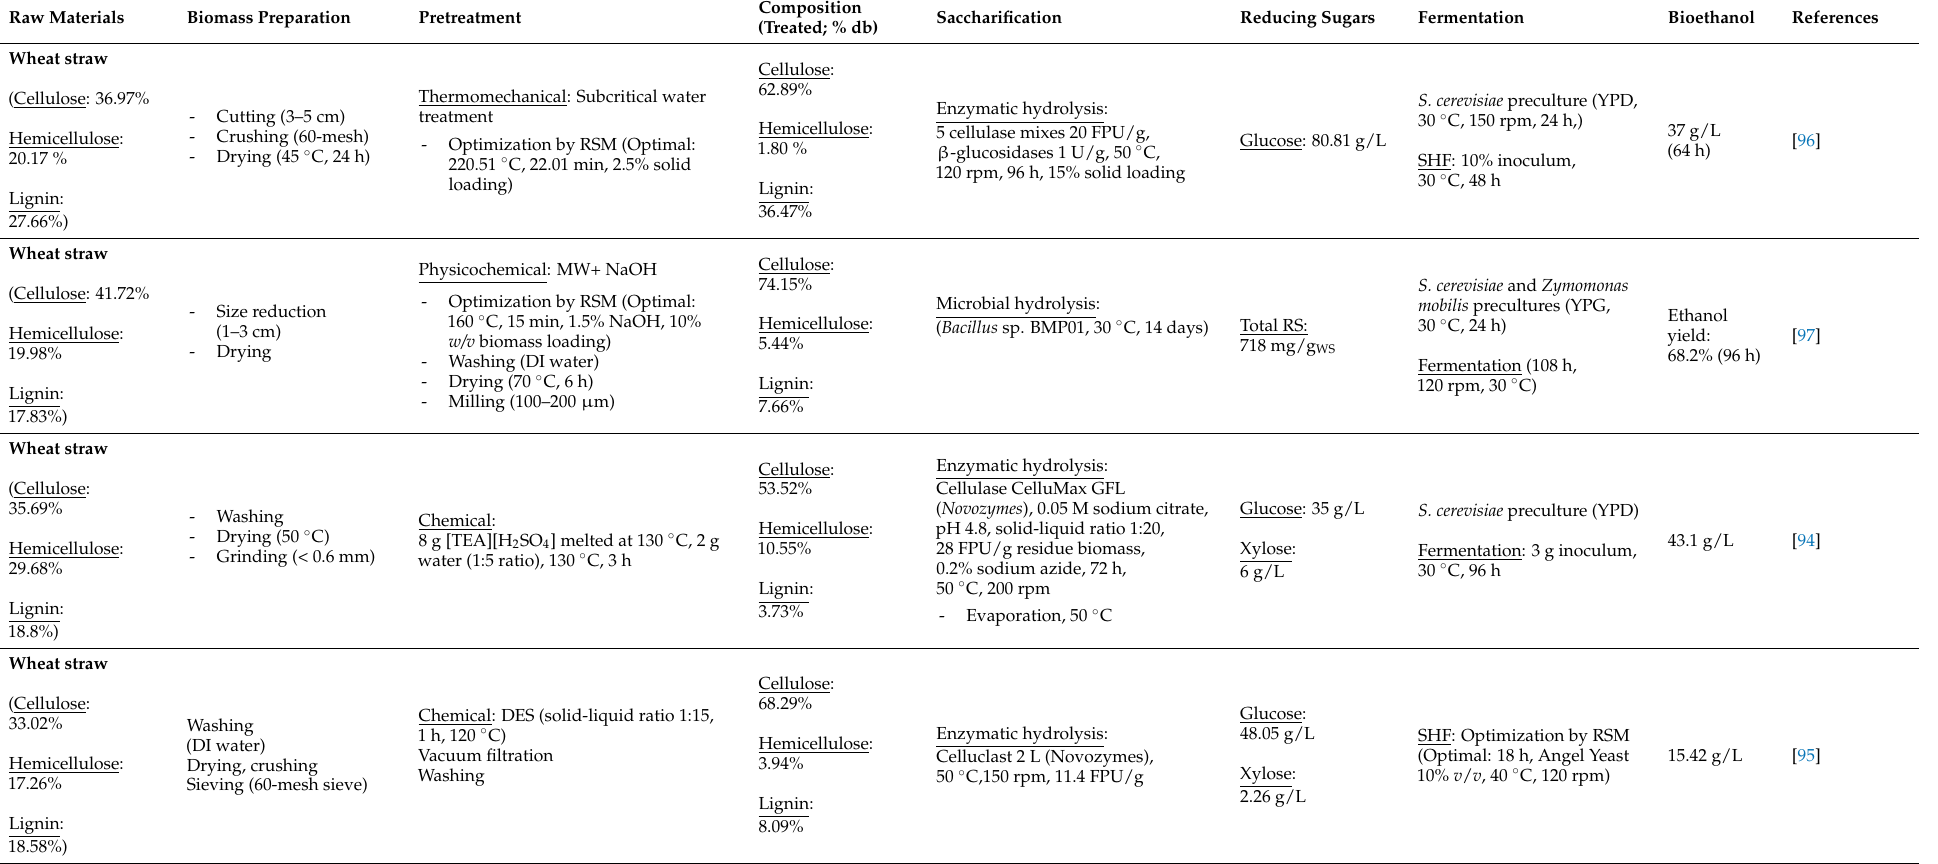
Table 5. Summary of experiments done for the pretreatment of wheat